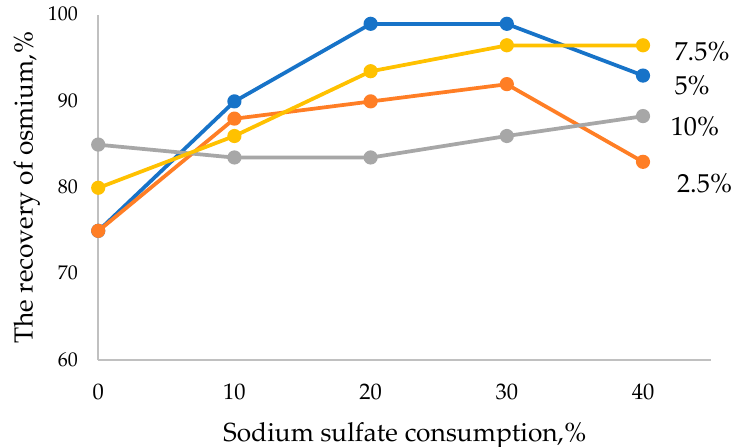
Figure 3. Effect of consumption of sodium sulfate and coke on the degree of extraction of osmium into the alloy.